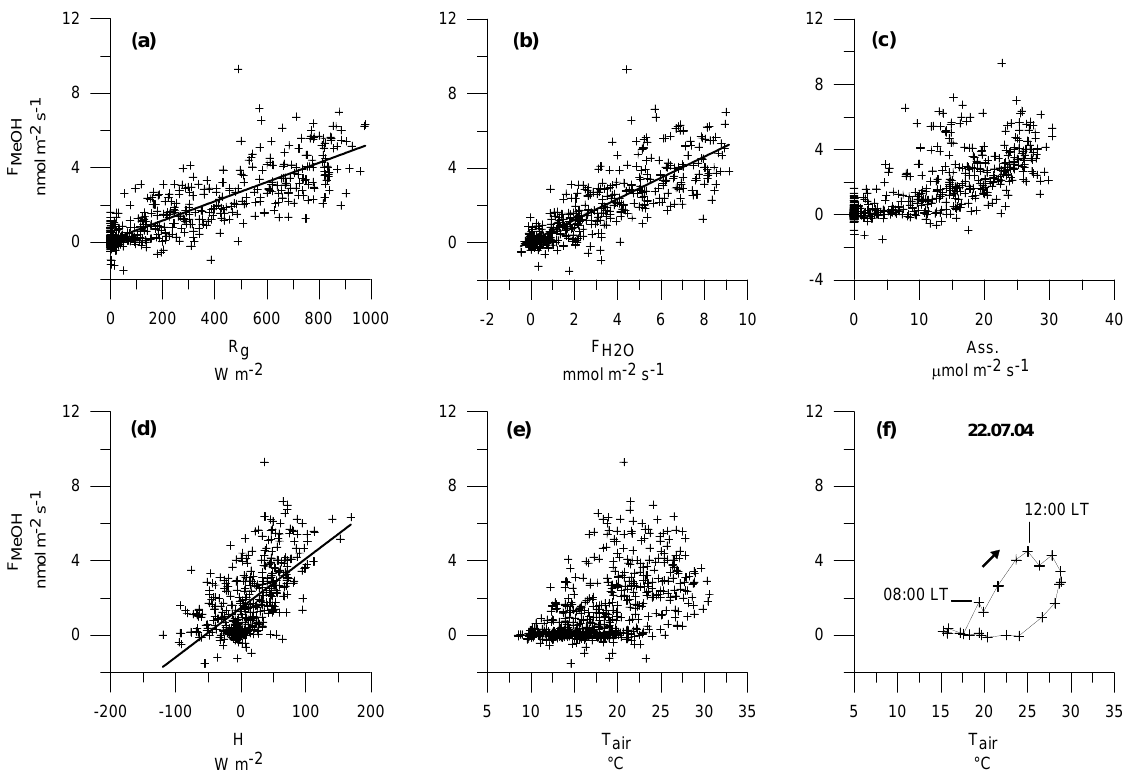
) , (c) assimilation (Ass.), (d) sensible 2 O